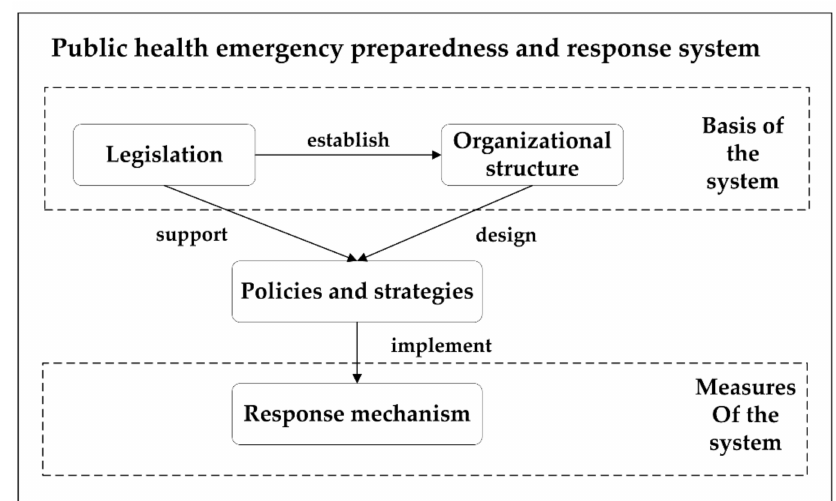
Figure 1. Public health emergency preparedness and response analysis